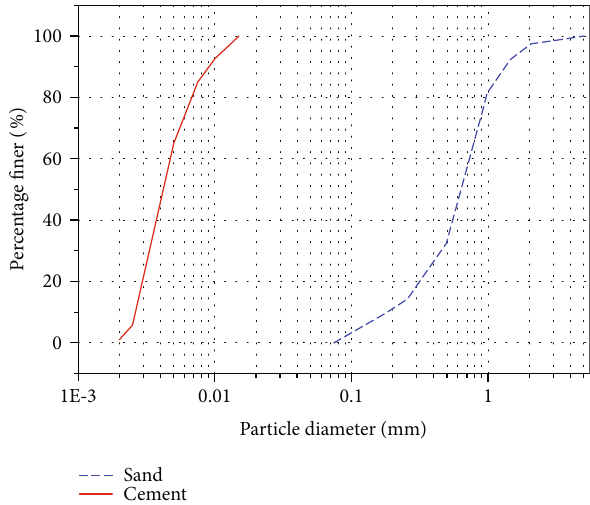
Figure 2: The gradation of cement and sand used in this